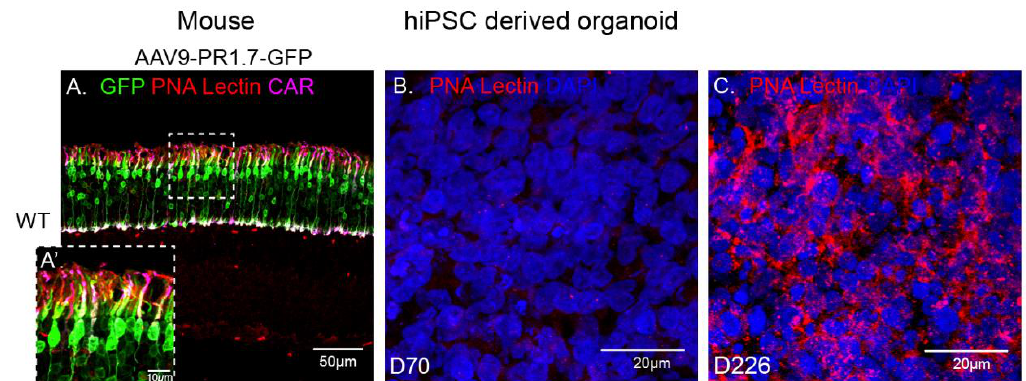
Figure 5. Immunofluorescence analysis of PNA lectin (red) in a mature wild-type mouse retina injected subretinally with AAV9-GFP, co-stained with cone arrestin (magenta) and DAPI (blue) ( A ) versus D70 ( B ) and D226 ( C ) hiPSC derived retinal organoids. Scale bar: 50 µm.